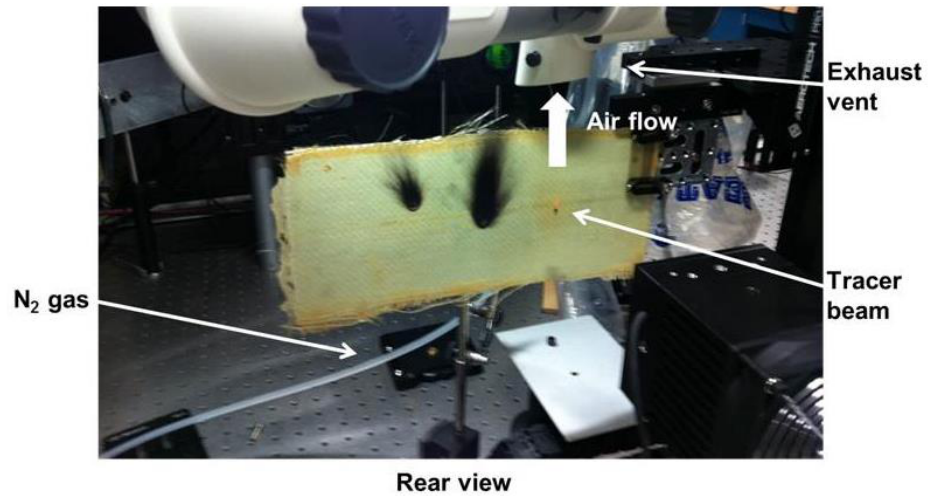
Figure 3. Test setup with the high power laser to measure the localized response of the embedded sensors to high